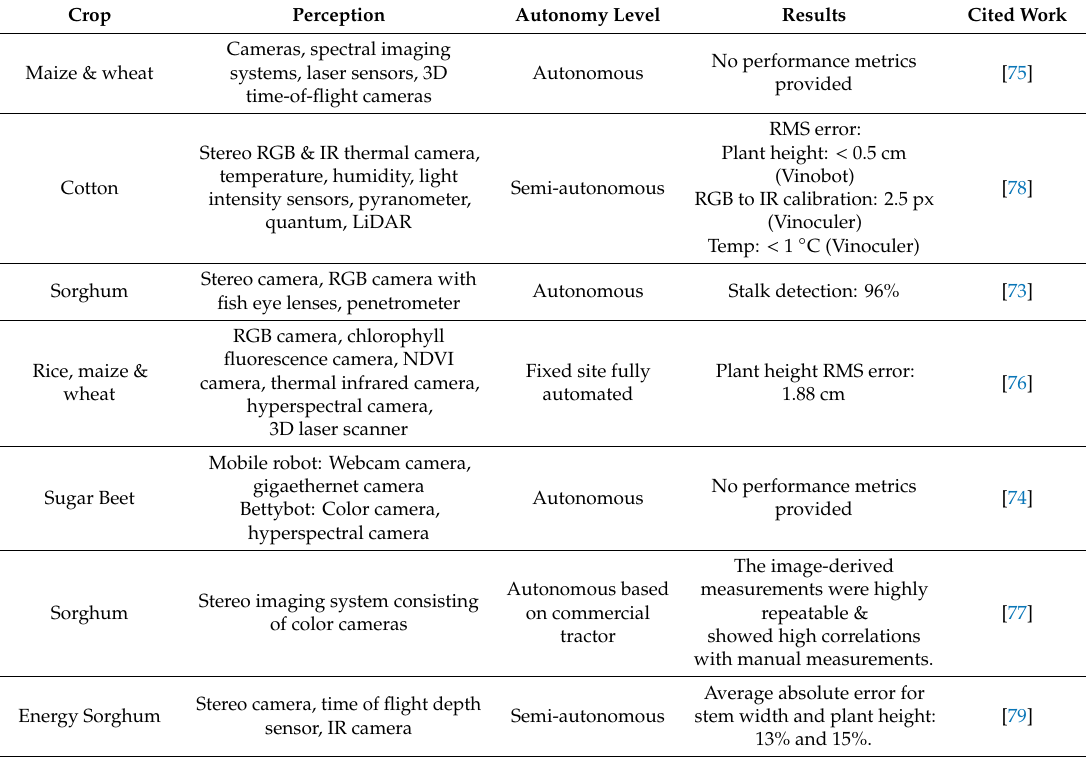
Table 5. Phenotyping agrirobotic systems for various